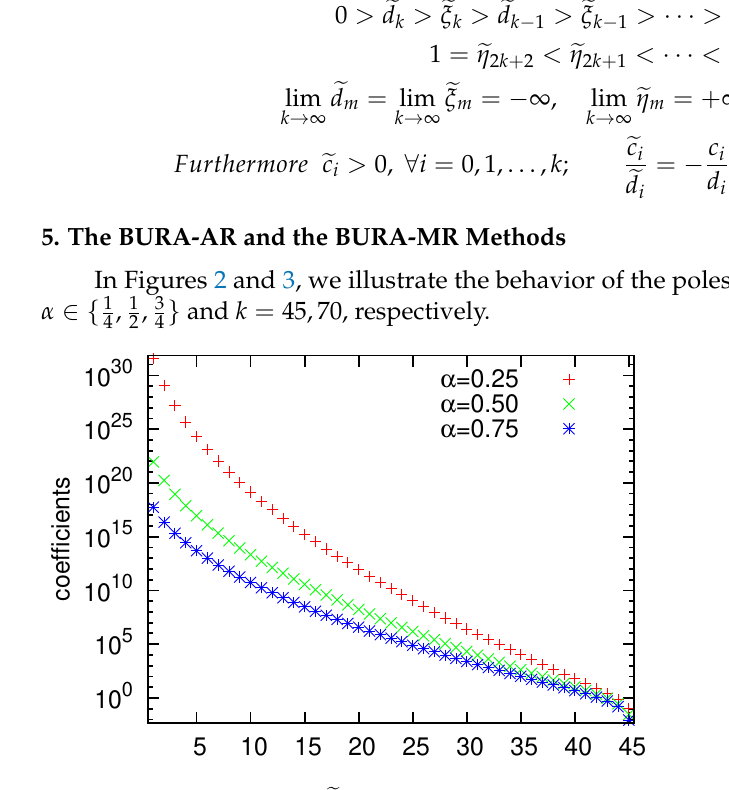
Figure 2. The coefficients − (cid:101) d i in the rational approximation of degree 45 of z − α for the values of α = 1 , 1 , 3 2 4 4